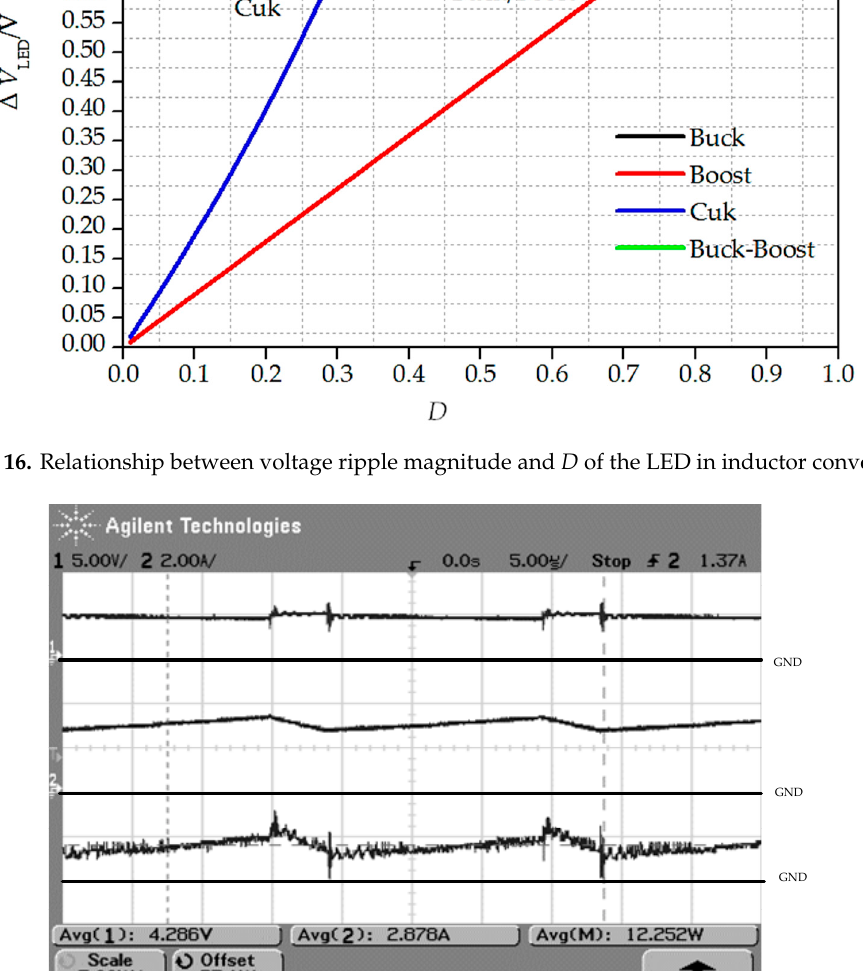
Energies 2019 , 12 , x FOR PEER REVIEW 23 of 28